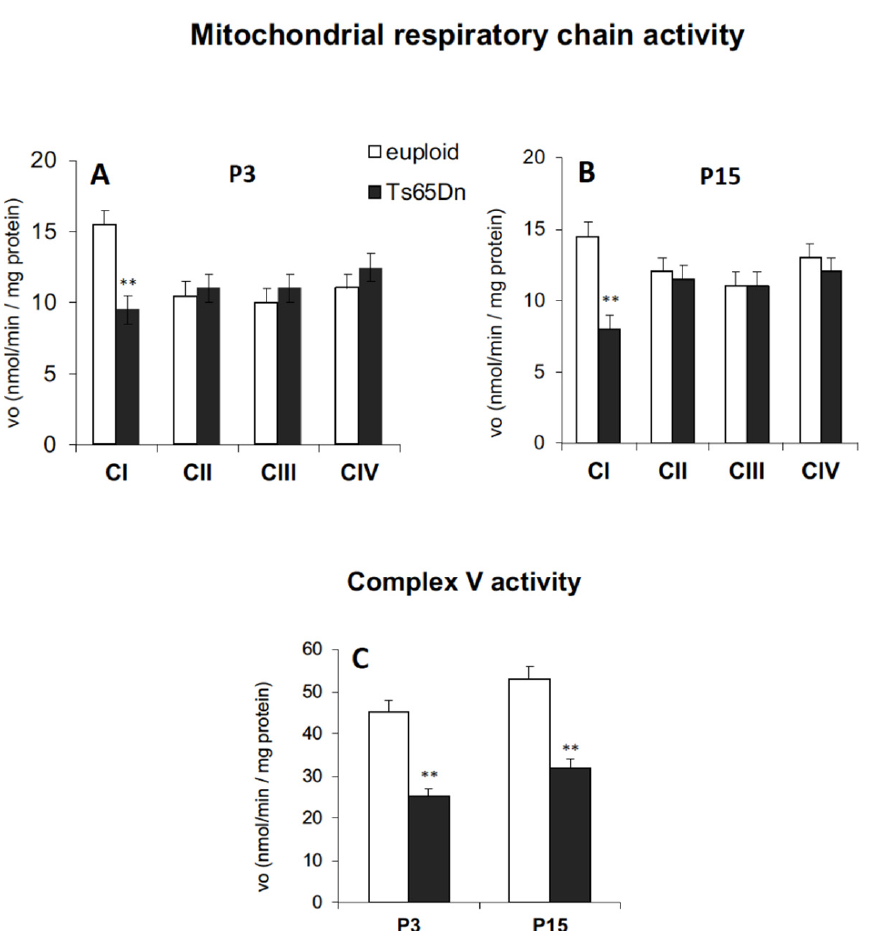
Figure 2. Reduced catalytic efficiency of MRC complex I and ATP synthase in Ts65Dn mouse brain. The activities of complex I, complex II, complex III, complex IV, ( A , B ) and complex V ( C ) were measured, as described in the Materials and Methods, in mitochondrial membrane-enriched fractions from cryopreserved P3 and P15 brain hemispheres of Ts65Dn mice and euploid mice. Rate values are the mean ± SD obtained in two independent measurements ( n = 4 mice for each experimental group). Group differences were evaluated with Tukey’s test. ** p < 0.01: Ts65Dn vs. euploid counterparts. Hippocampal neurogenesis and dendritic spine growth are strictly dependent on mi- tochondrial energy [10,39]. Given the proven efficacy of neonatal treatment with 7,8-DHF in restoring both these processes [33], we evaluated the effect of 7,8-DHF on mitochon- drial energy efficiency. For this purpose, we monitored ATP production via OXPHOS in mitochondria isolated from the hemispheres of Ts65Dn and euploid mice aged 15 days subcutaneously administered with either 7,8-DHF (5 mg/kg/day) or the vehicle, during postnatal period P3–P15. We found that, in Ts65Dn mice, treatment with 7,8-DHF triggered complete recovery in the rate of complex I- and II-dependent mitochondrial ATP synthesis (Figure